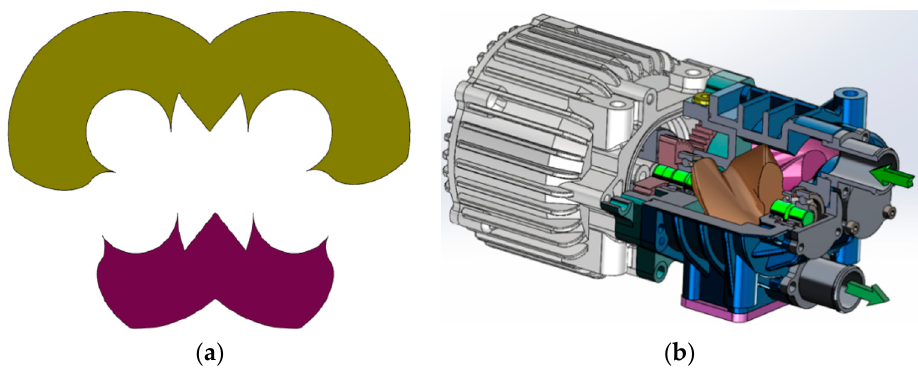
Figure 2. ( a ) Suction and discharge ports; and ( b ) structure of the pump.